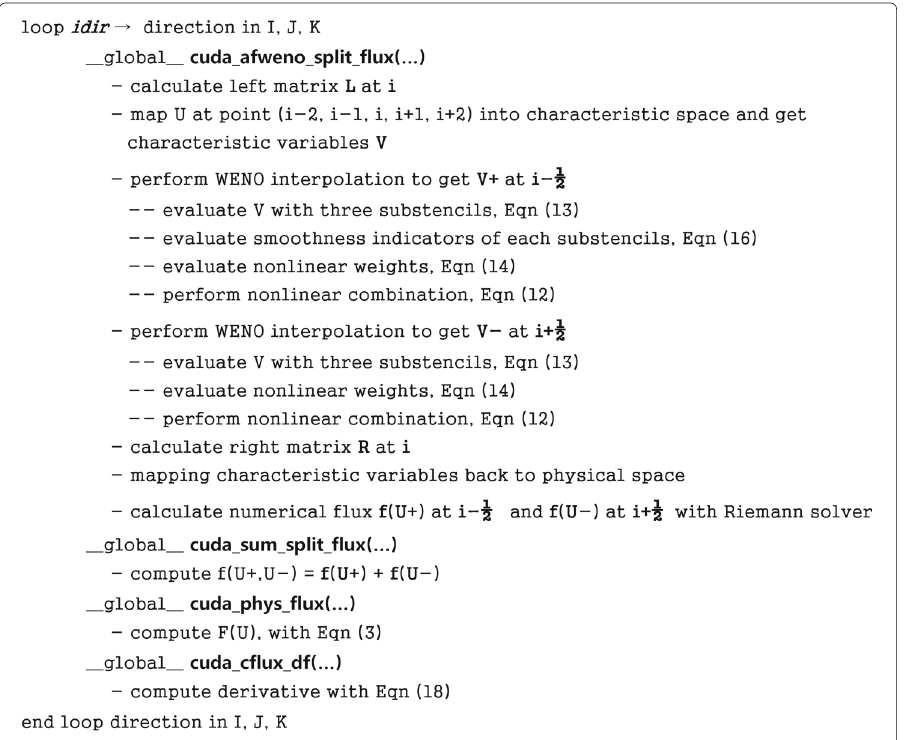
Fig. 11 Code structure of derivative of inviscid flux computed with modified AFWENO